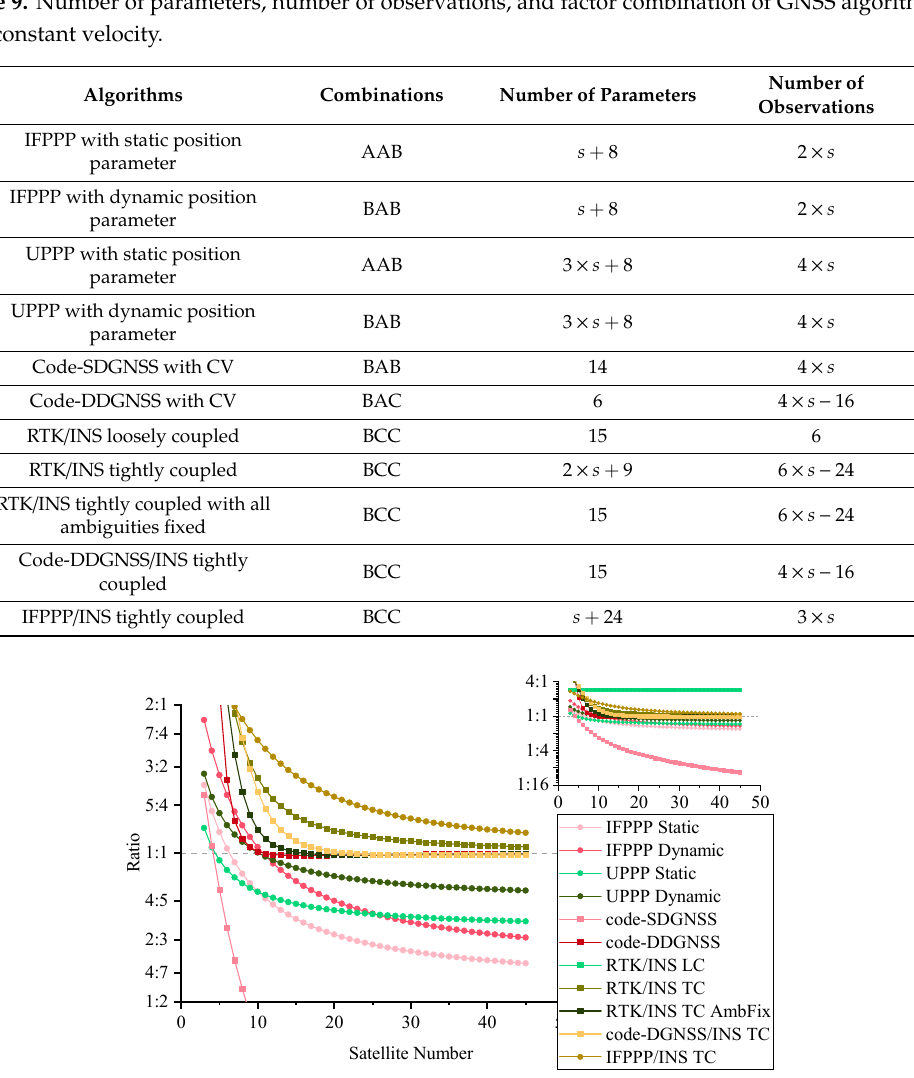
t t for GNSS algorithms. Figure 4. Computational cost ratio t Info Kal Info / t Kal for GNSS